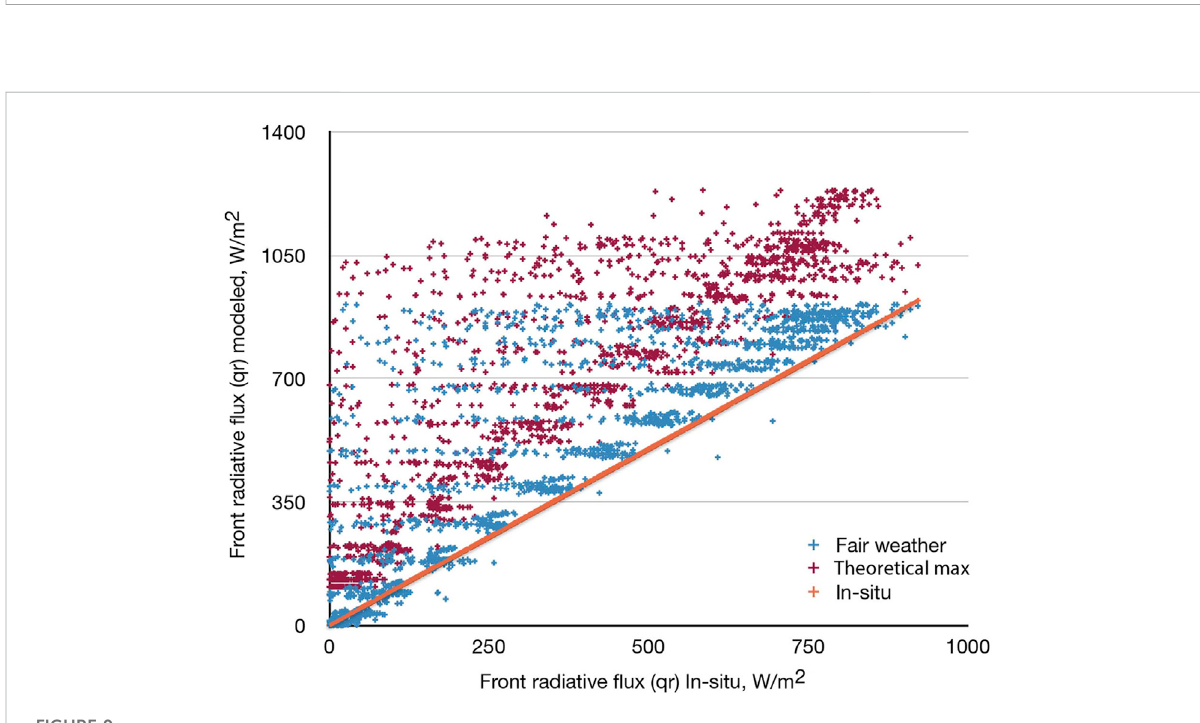
FIGURE 9 Front side radiative transfer